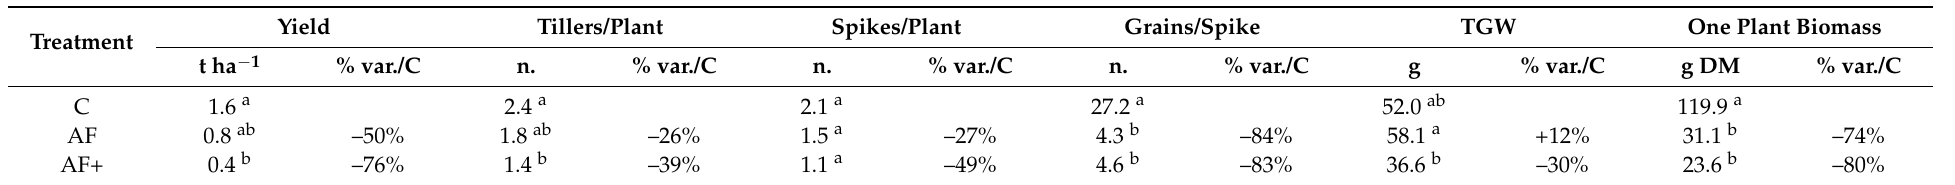
Table 3. Yield and yield components of the durum wheat cultivar 1 in three treatments (C, AF and AF+), as the average of 2015–16 and 2016–17 wheat growing seasons (n = 4). TGW: thousand-grain weight. Yield and yield components in AF and AF+ treatments are also expressed as percentage variation vs. controls. Means with different letters are significantly different according to the Tukey’s HSD test ( p ≤